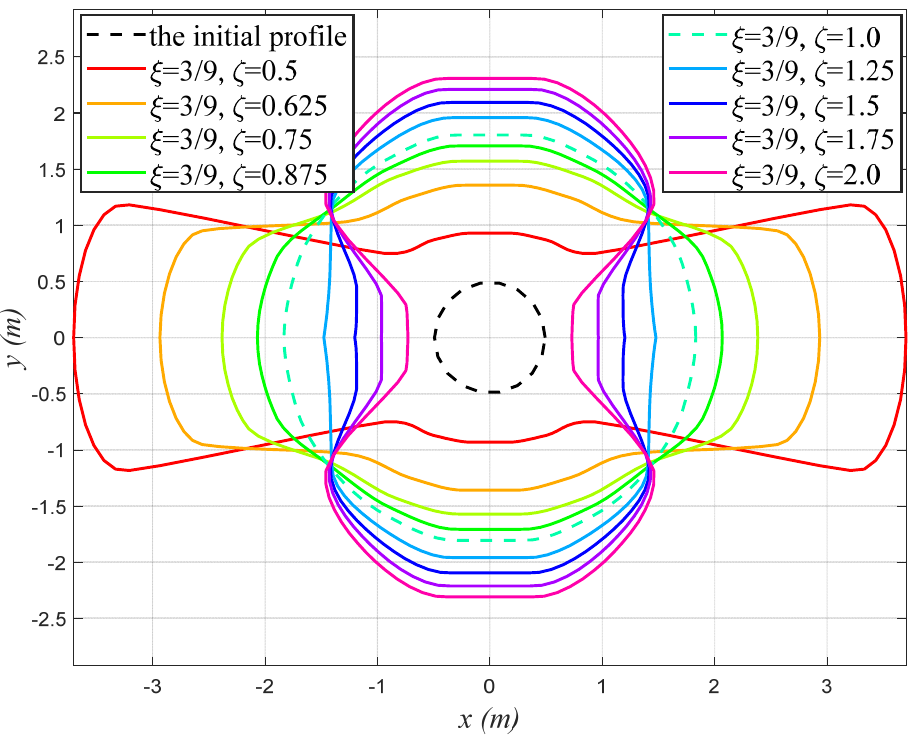
Figure 16. Fracture profiles on the plane xoy of Group 2 experiments under ξ = 3/9 at the moment = 20 s .